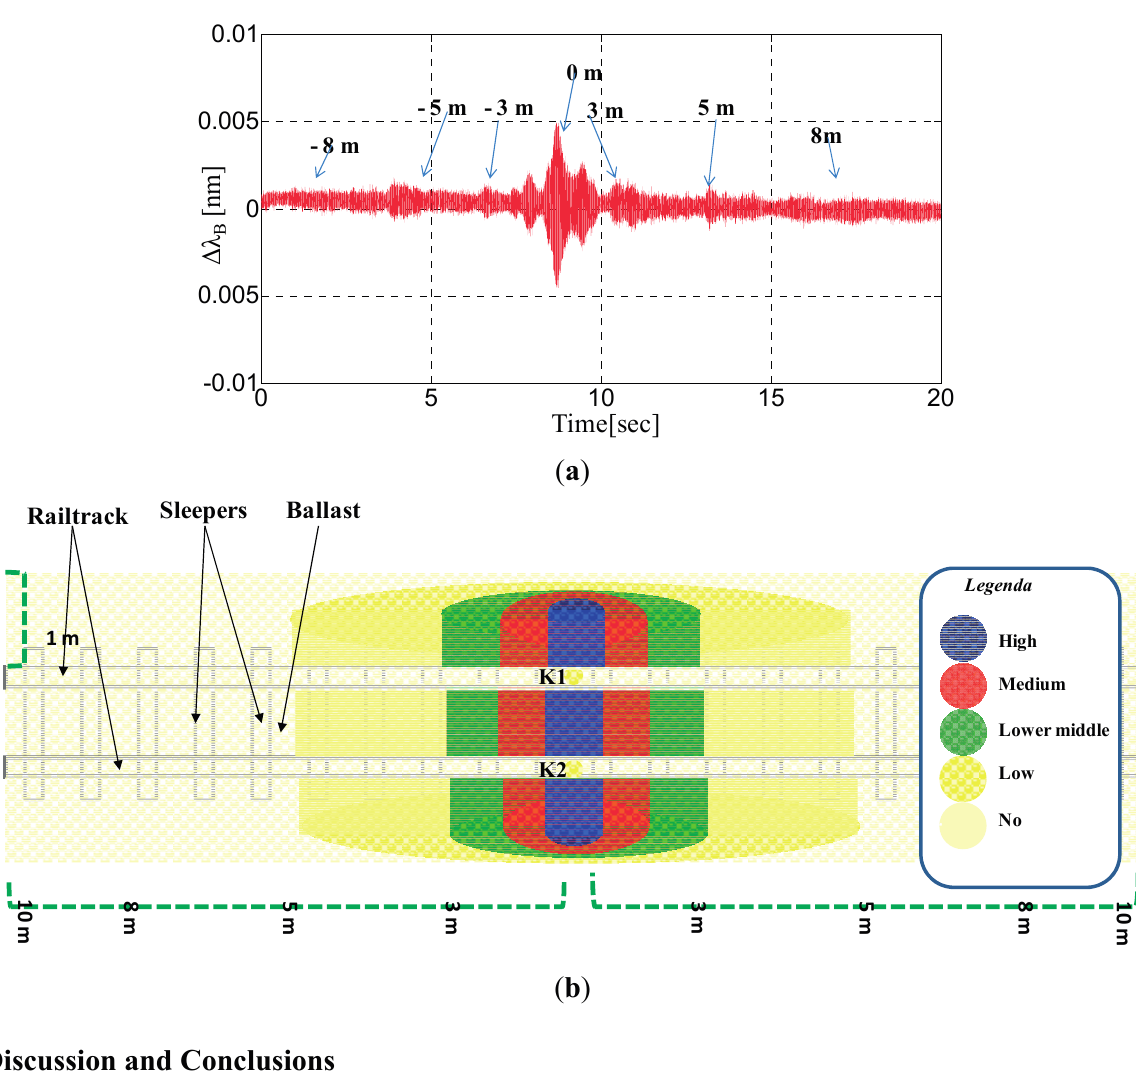
Figure 16. ( a ) Bragg wavelengths of the accelerometer K1 vs . time when the intruder walks outside and parallel at a distance of 80 cm from the rail (side A); ( b ) Schematics of the detection zone for FBG accelerometers sensing